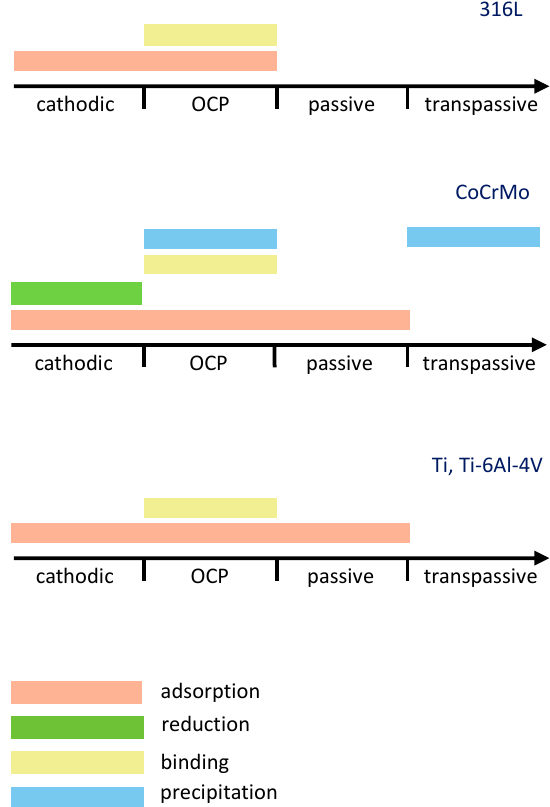
Figure 10. Effect of electrochemical potential on the occurrence of albumin-related phenomena as a result of interaction of albumin with 316L steel, CoCrMo, Ti and Ti-6Al-4V alloys.